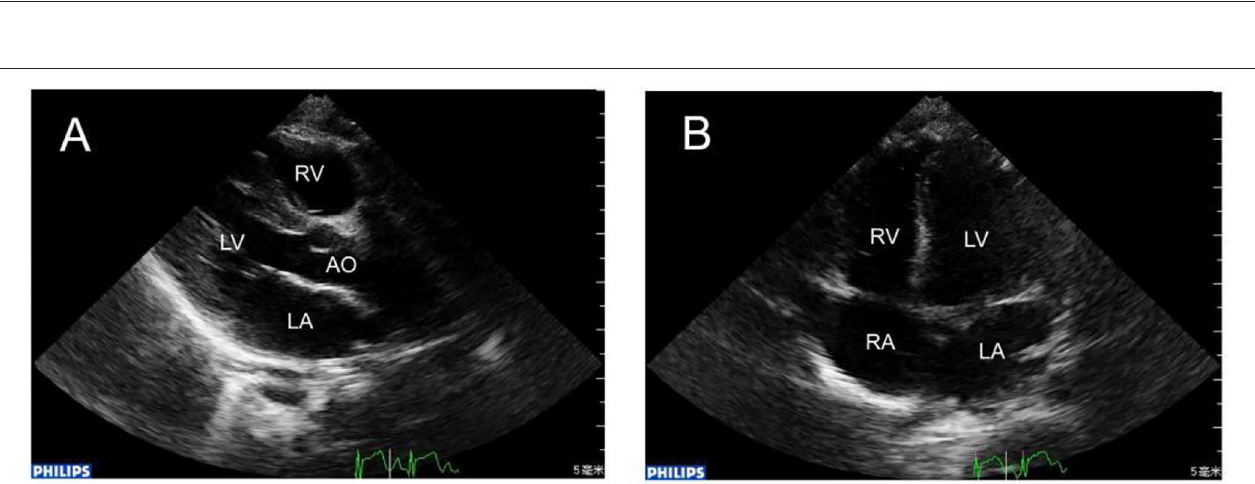
Frontiers in Pediatrics | www.frontiersin.org